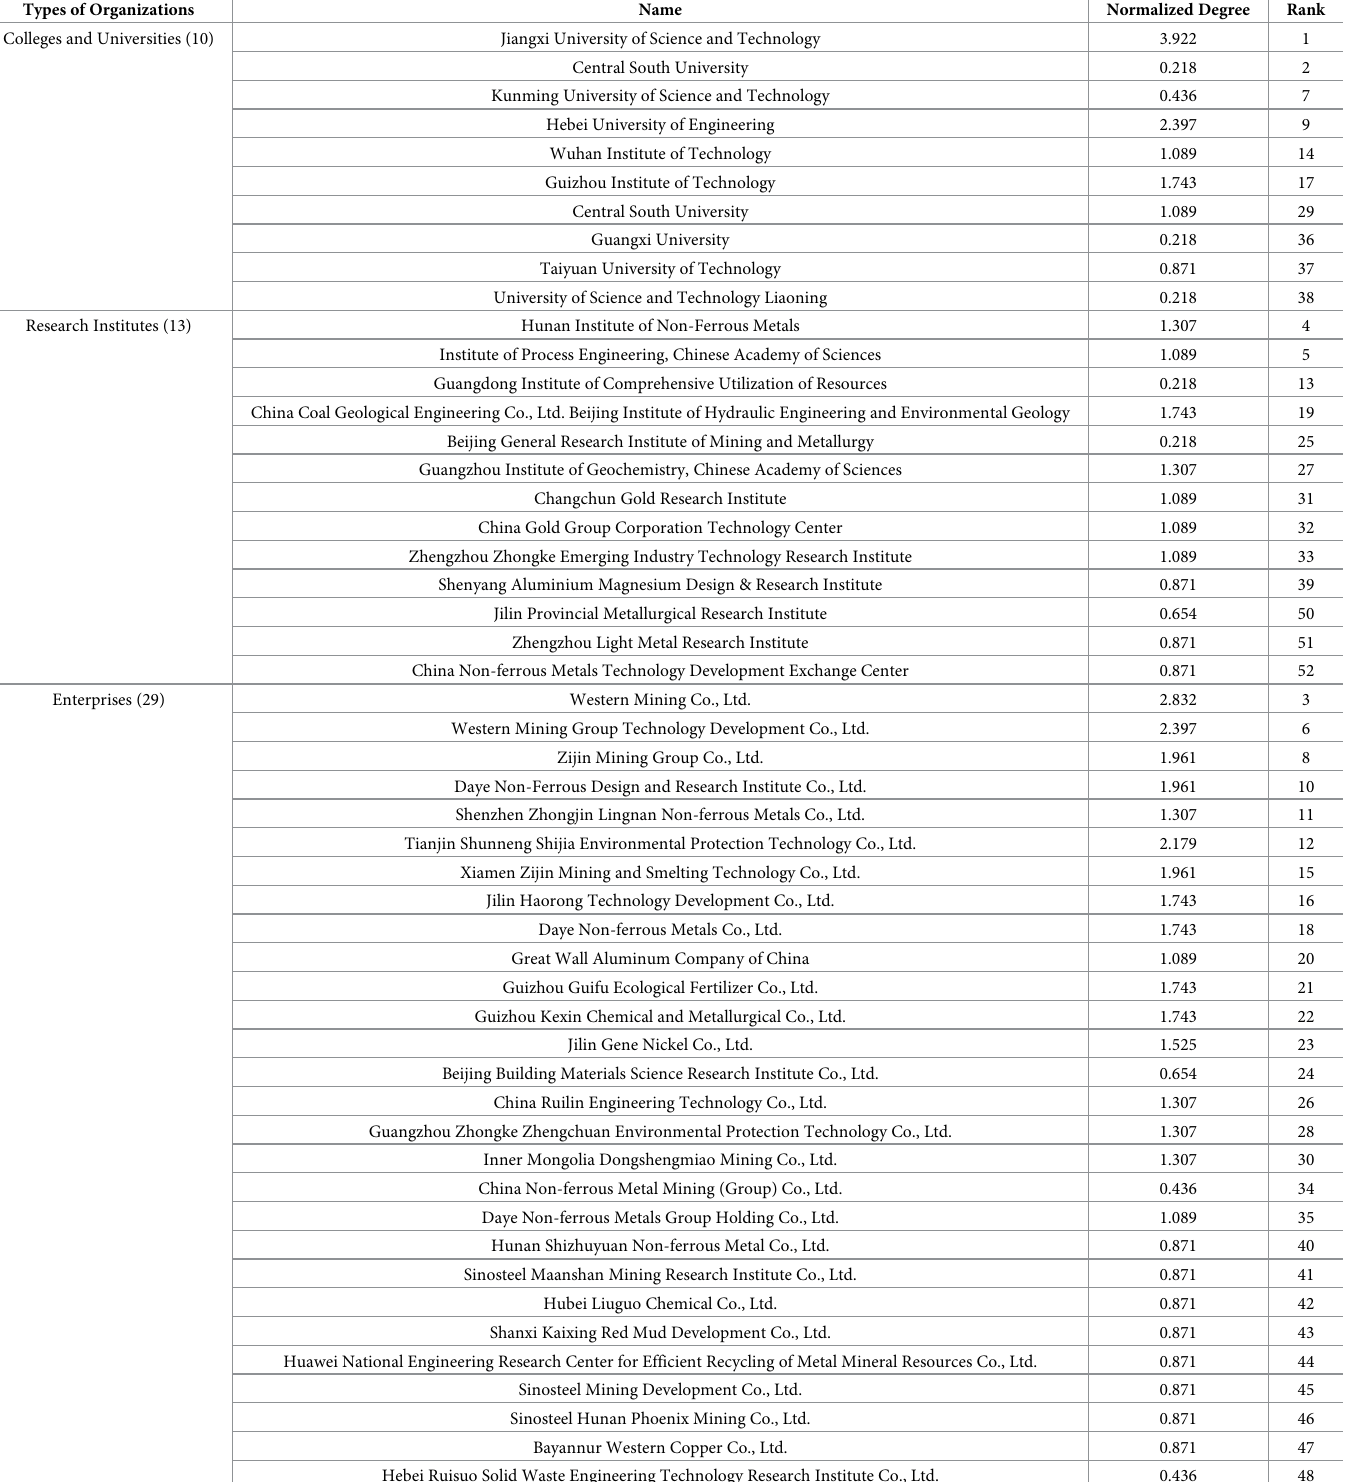
Table 2. Classification of major patent cooperative organizations. Types of